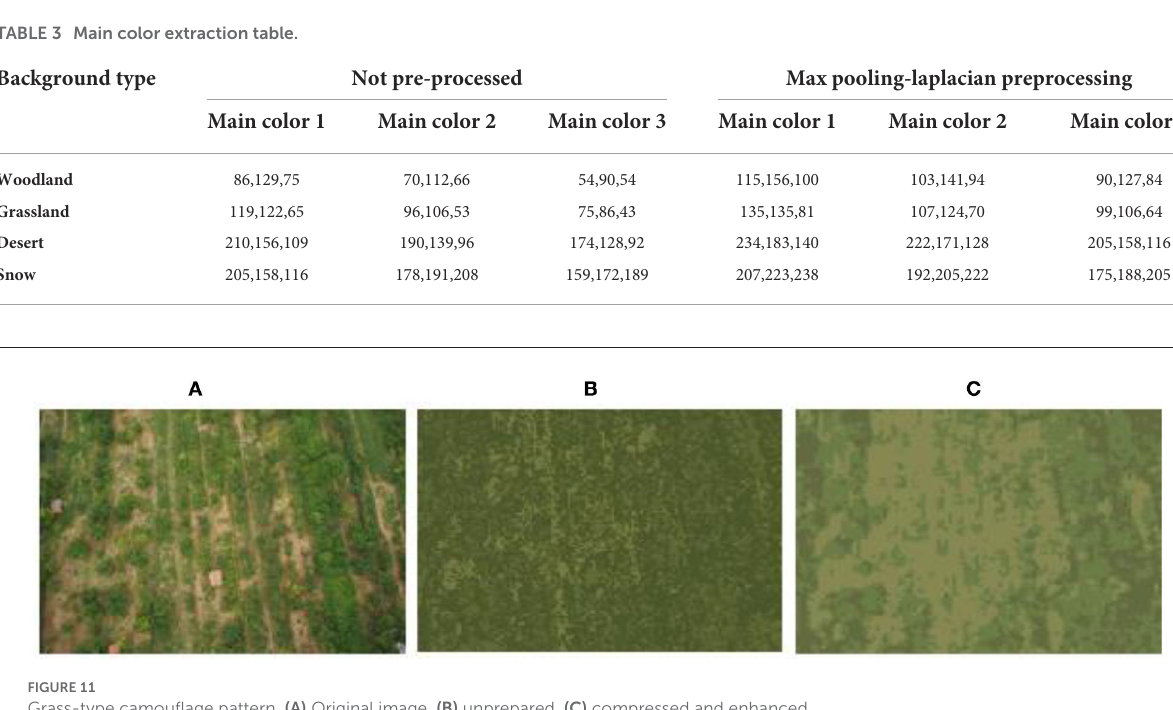
invariant moment set feature vector and calculate the Euclidean distance and cosine distance between the